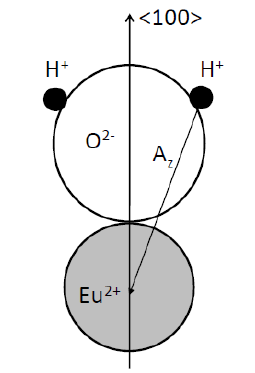
O couple in CsBr:Eu 2+ , consistent with the EPR 2